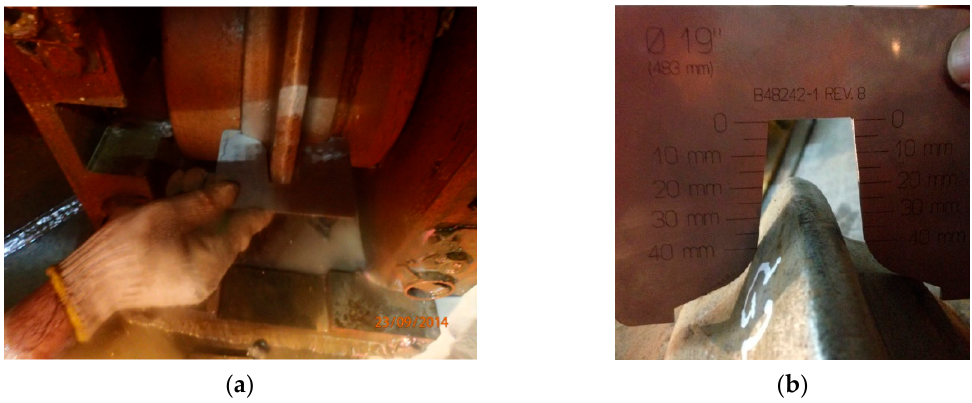
Figure 5. Disc cutter configurations of cutterhead. A carbon steel pipe with a diameter, length, and thickness of 20.32 cm, 6 m, and 13 mm, respectively, was used as the slurry discharge pipe at the project site. The thickness of the pipes was measured every week using an ultrasonic thickness gauge at the base where the maximum wear occurred. The pipes were rotated by approximately 120° once the residual thickness of the pipe reached 6 mm to maximize the life cycle of the pipes; otherwise, the pipes were replaced. Measurements were recorded at three locations, i.e., at the front, middle, and rear of each pipe, based on the direction of the excavation. Figure 6 shows a site where the pipe thickness was measured and the location of the pipe measurement.